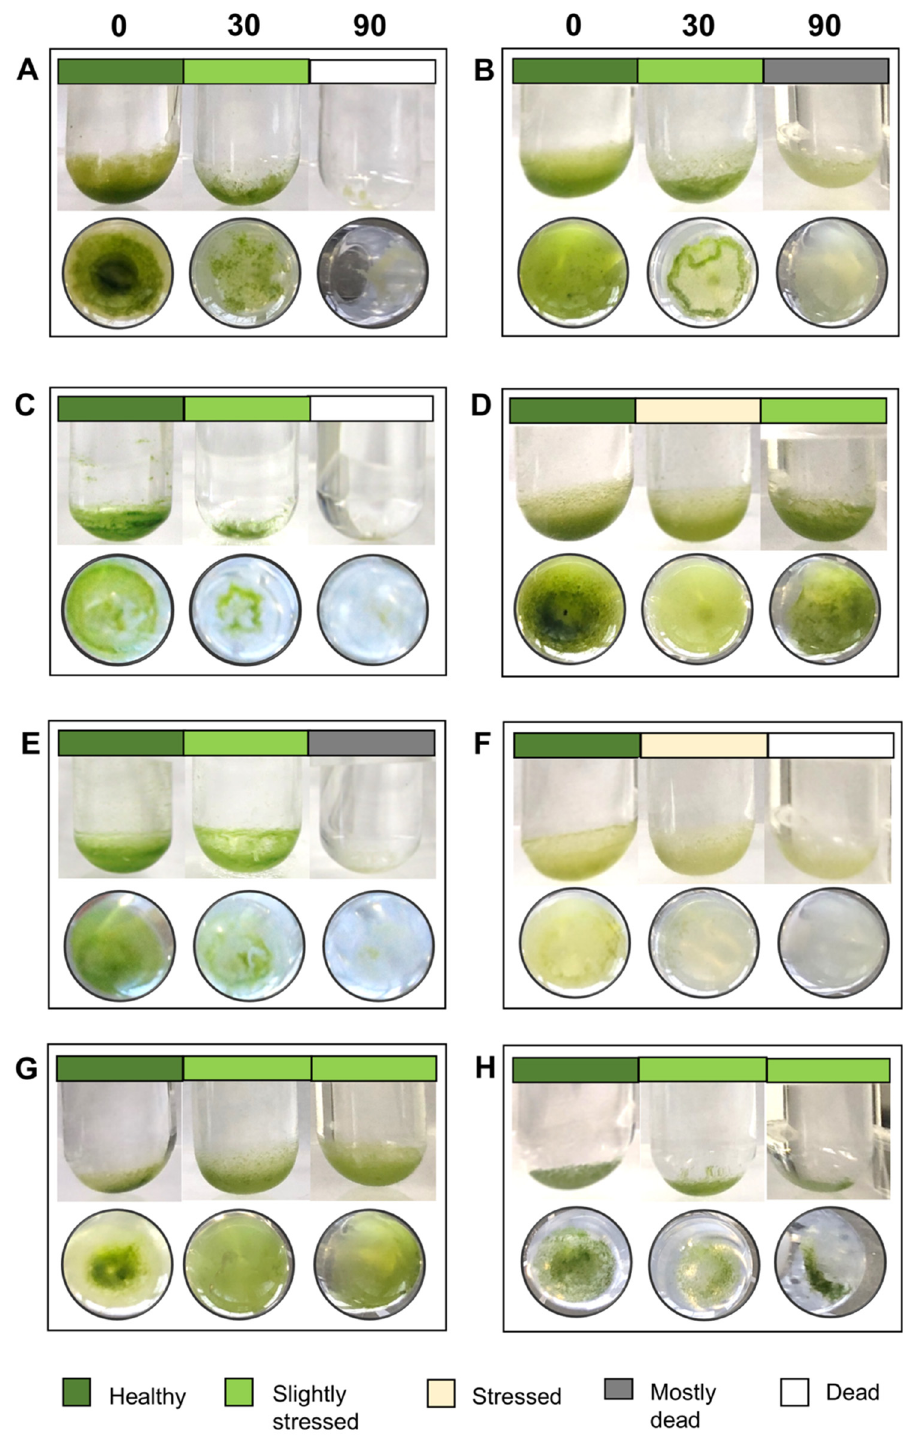
Figure 3. ( A ) SAG 56.91 Stichococcus bacillaris; ( B ) Protostichococcus edaphicus SAG 2481; ( C ) Deuterostichococcus marinus ASIB-IB-37; ( D ) Tritostichococcus solitus SAG 2406; ( E ) Tetratostichococcus jenerensis J1302; ( F ) Diplosphaera epiphytica SAG 11.88; ( G ) Pseudostichococcus monallantoides SAG 380-1; ( H ) Desmococcus olivaceus SAG 1.92. Clumping was observed in ( A – C ).